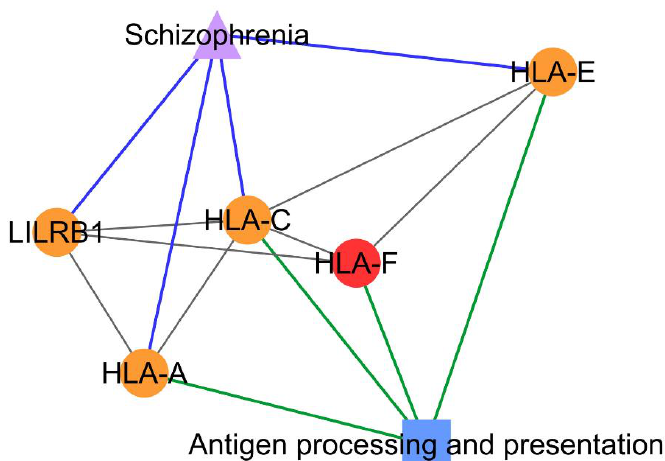
Figure 3. PCOS–disease subnetwork 8. This subnetwork showed shared proteins and shared pathway (long- term potentiation) between PCOS and ovarian cancer. Different coloring of nodes and lines represents PCOS-related proteins (red), shared proteins (orange), PCOS–disease interactions (blue), and protein– pathway interactions (green). Shape of nodes denotes PCOS-related proteins (circle), disease (triangle), and pathway (square).